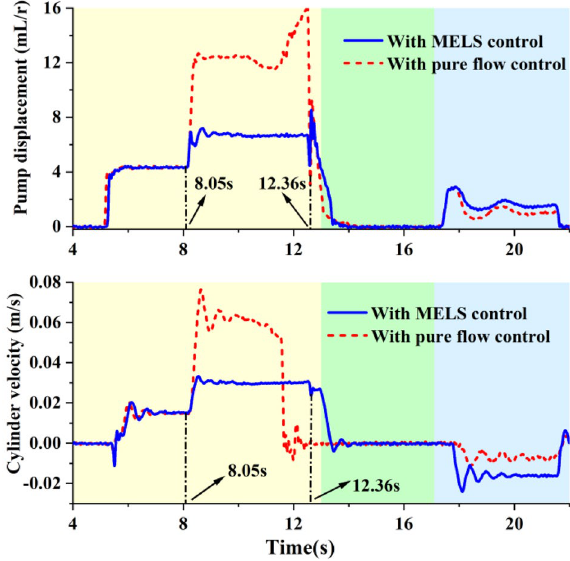
Figure 7 Pump displacement and actuator velocity